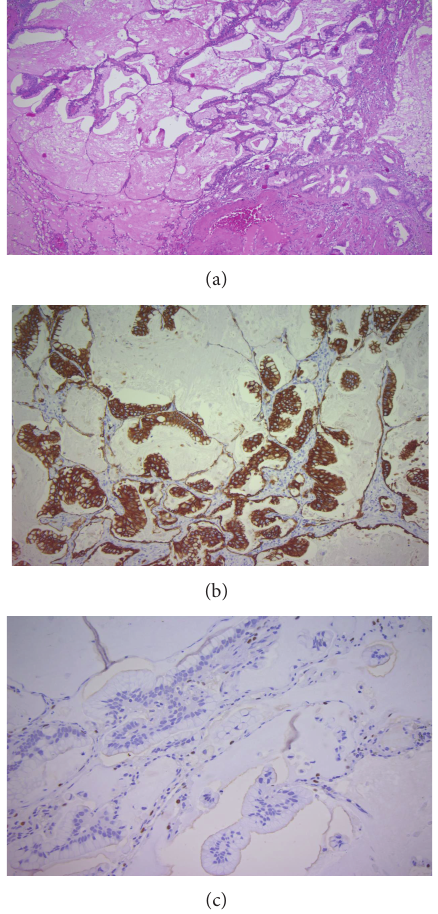
Figure 2: (a) HE-staining of the tumor clearly demonstrates a lepidic growth pattern ( × 50). (b) The tumor cells display a strong expression of CK7. (c) The tumor cells are negative for TTF-1 on immunohistochemistry (note positive internal control).